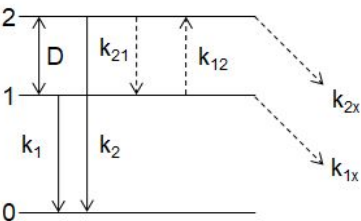
Figure 6. Energy level diagram used for the description of the excited states dynamics of the Bi 3 + -related luminescence centers responsible for the UV emission. For details, see the text.